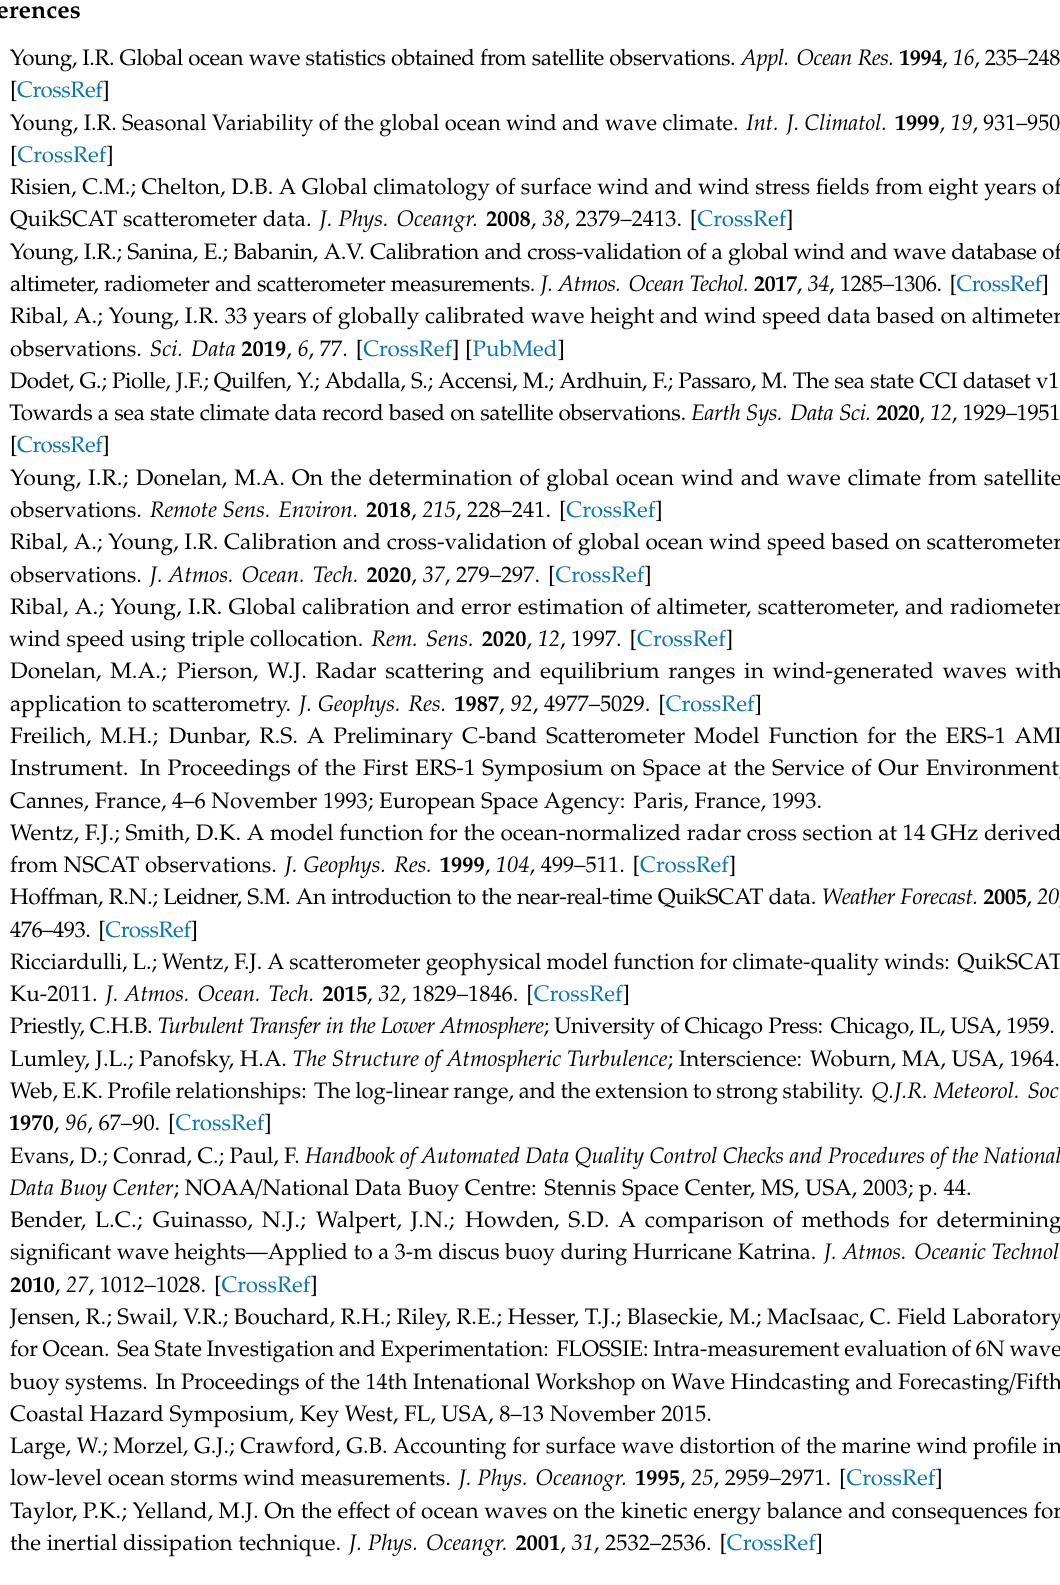
Data Access: The scatterometer data used for the analysis are available from the Australian Ocean Data Network (AODN) https: // portal.aodn.org.au / . The ocean basin scale and near-coastal processed monthly mean and percentile data, as well as the 100-year return period data, are archived as NetCDF files at https: // figshare.com / s /